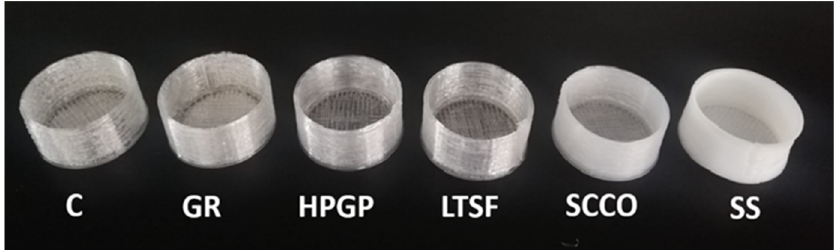
Figure 9. Image of 3D ‐ printed PLA well samples before (untreated control C) and after five sterilisation processes: (GR) gamma radiation, (HPGP) hydrogen peroxide gas plasma, (LTSF) low temperature steam formaldehyde, (SCCO) supercritical CO 2 and (SS) saturated steam.